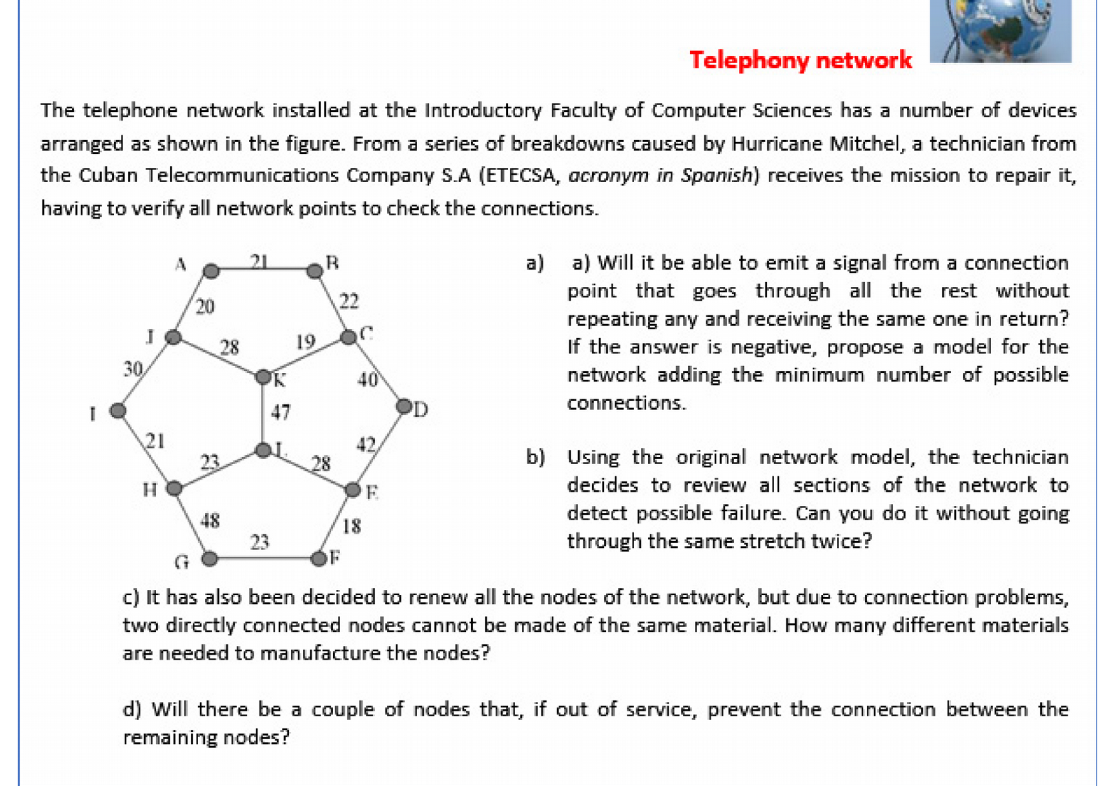
Figure 2. Problem (learning situation) designed for the PBL in the